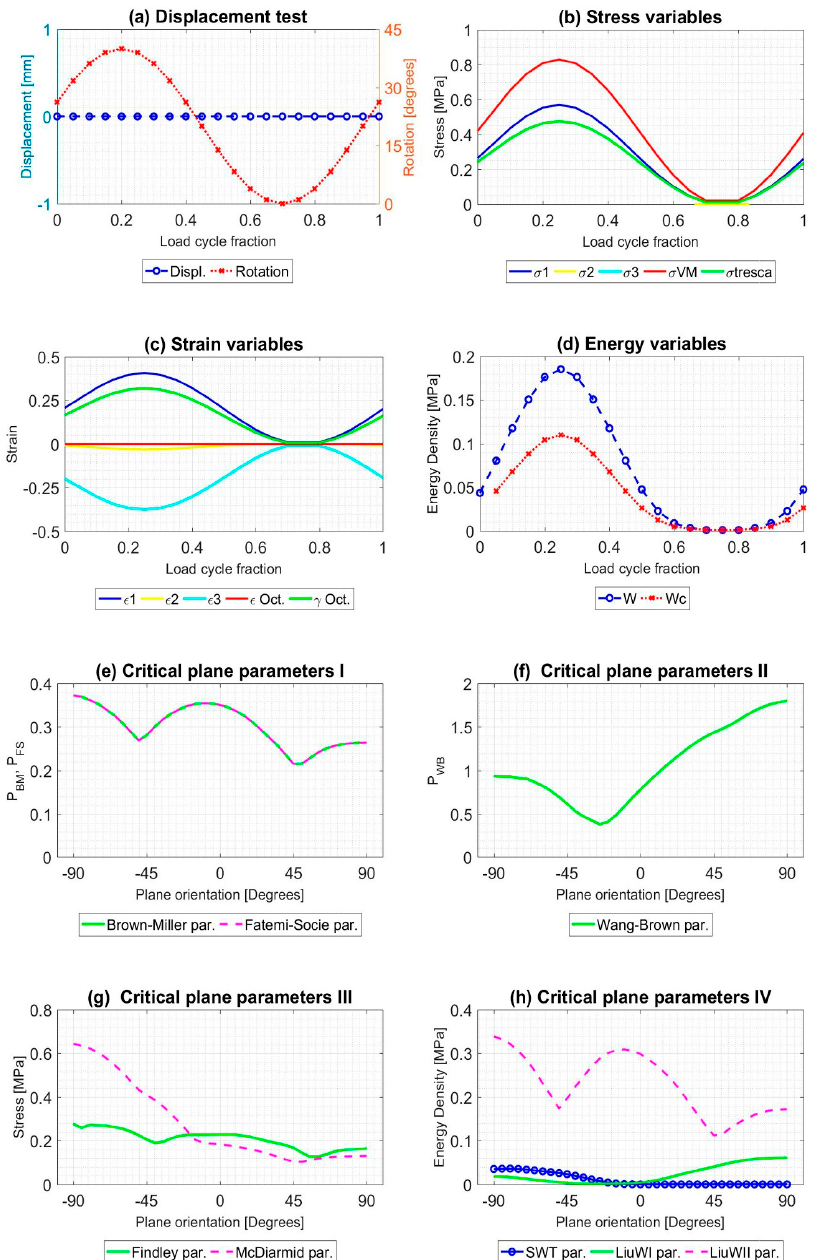
Figure 9. Result of the mechanical simulation of test B9 at the failure point of the sample caused by fatigue. Initial data from [46]